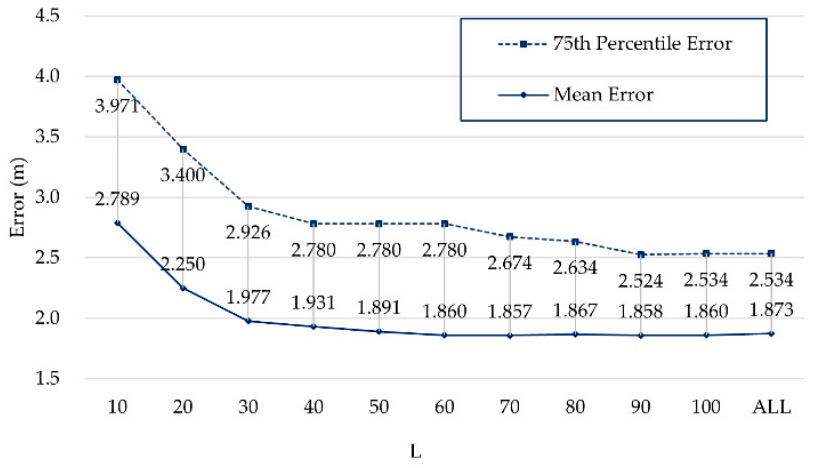
Figure 8. Positioning errors of different L on Zenodo.